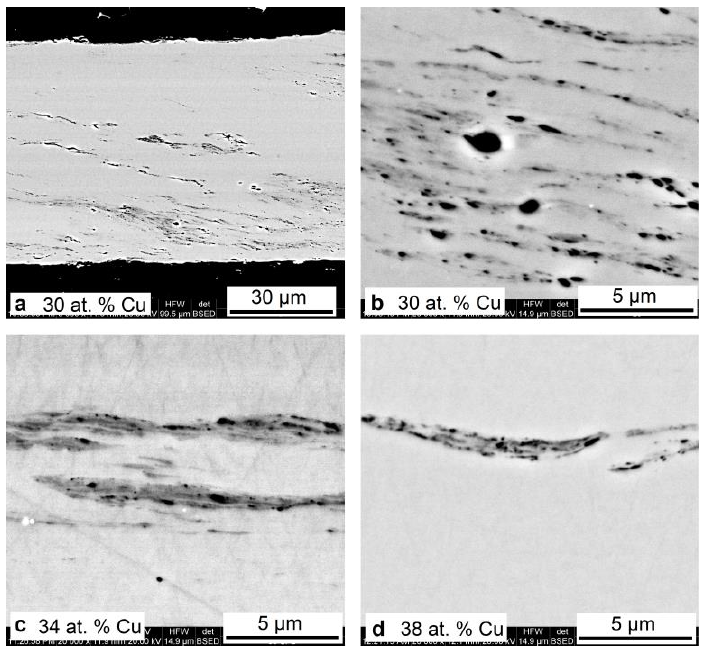
Figure 4. Cross section of the melt spun TiNiCu ribbons containing 30 at.% Cu ( a,b ), 34 at.% Cu ( c ), and 38 at.% Cu ( d ) after high-pressure torsion (HPT) to n = 5.